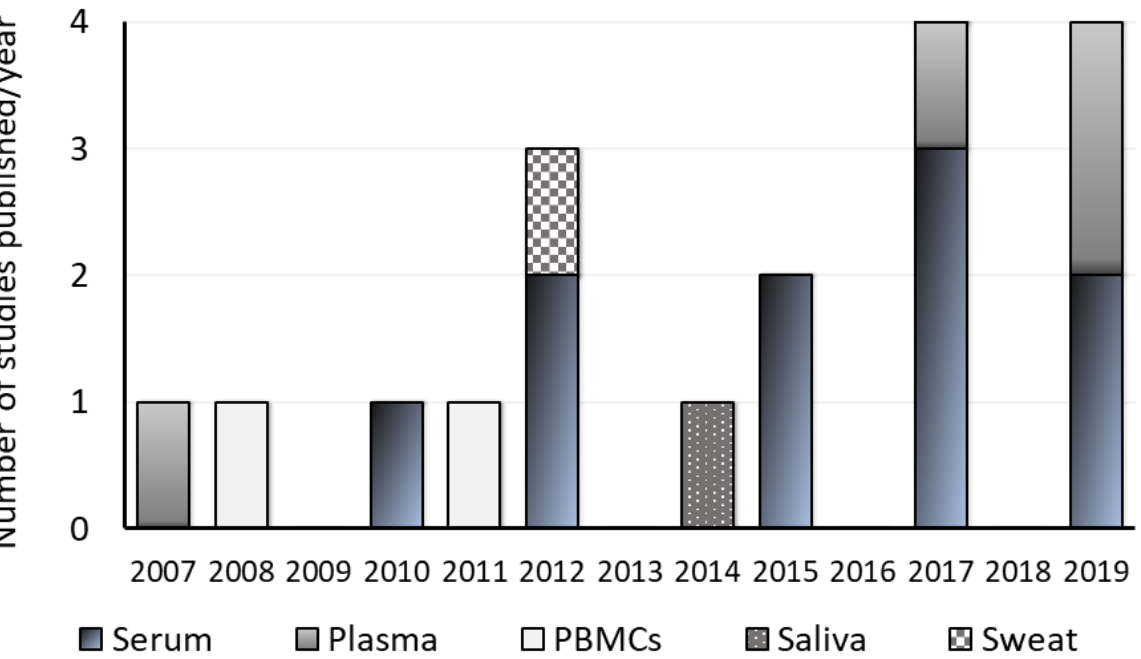
Figure 3. Sample type. The image shows the number of publications per year that fit the criteria of this review. Each color shows the type of samples used, and its height indicates the number of stud- ies.